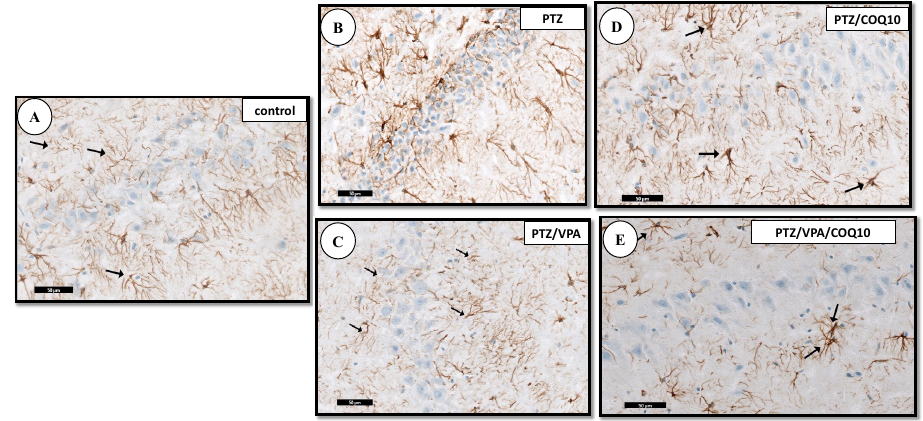
Figure 8. A photomicrograph of the CA3 region of the hippocampus of all of the rat group. ( A ) Control group showing the positive reaction for GFAP immuno-staining in the cytoplasm of astrocytes ( ↑ ). ( B ) PTZ showing an apparent increase of the positive brownish reaction for GFAP immuno-staining in the cytoplasm of astrocytes, compared to that of group I (the negative control, non-epileptic rats). ( C ) PTZ/VPA showing an apparent decrease of the positive brownish reaction for GFAP immuno ‐ staining in the cytoplasm of the astrocytes. Notice that the astrocytes present shorter processes ( ↑ ) compared to those of group II (the epileptic model group). ( D ) PTZ/COQ10 showing the apparent moderate decrease of the positive brownish reaction for GFAP immuno ‐ staining in the cytoplasm of the astrocytes. ( E ) PTZ/VPA/COQ10 group showing the apparent decrease of the positive brownish reaction for GFAP immuno ‐ staining in the cytoplasm of the astrocytes.